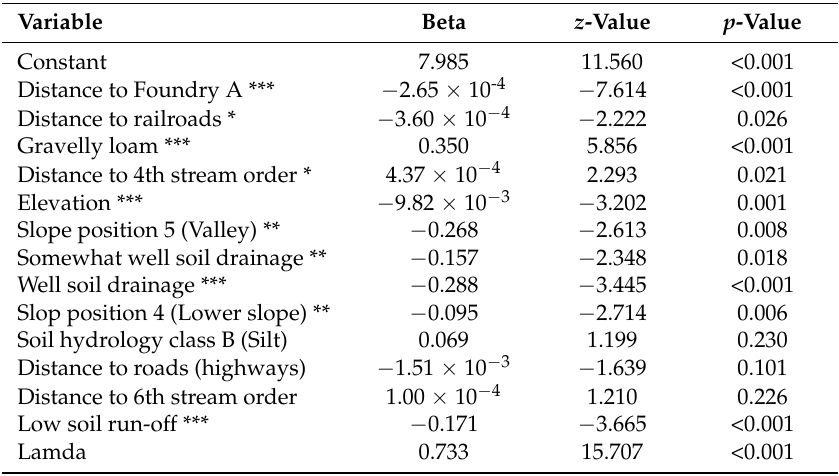
Table 4. Estimated results of regression models of pollution hazard intensity, as a function of physical profiles; Spatial error regression. Model 2. Spatial Error Regression Model for Physical Variables- R 2 =